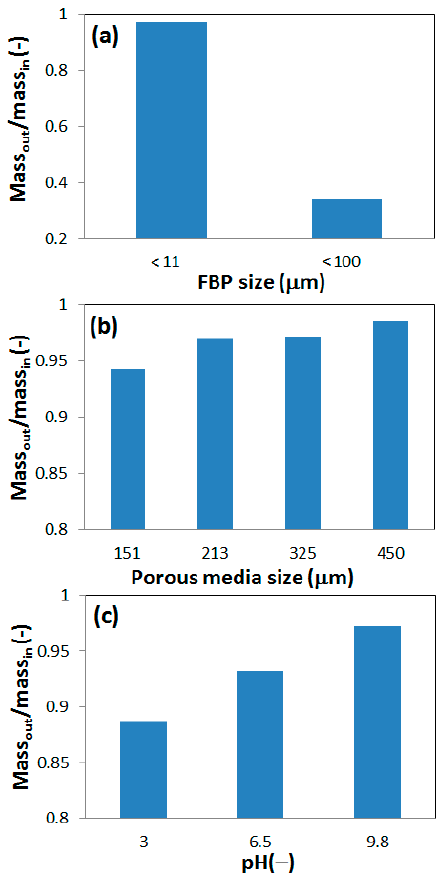
Figure 9. Ratio of outflow to inflow mass of FBPs in column experiments for: ( a ) FBPs filtered to sizes <11 μ m and <100 μ m, respectively; ( b ) different porous media grain sizes; ( c ) different pH of solution.